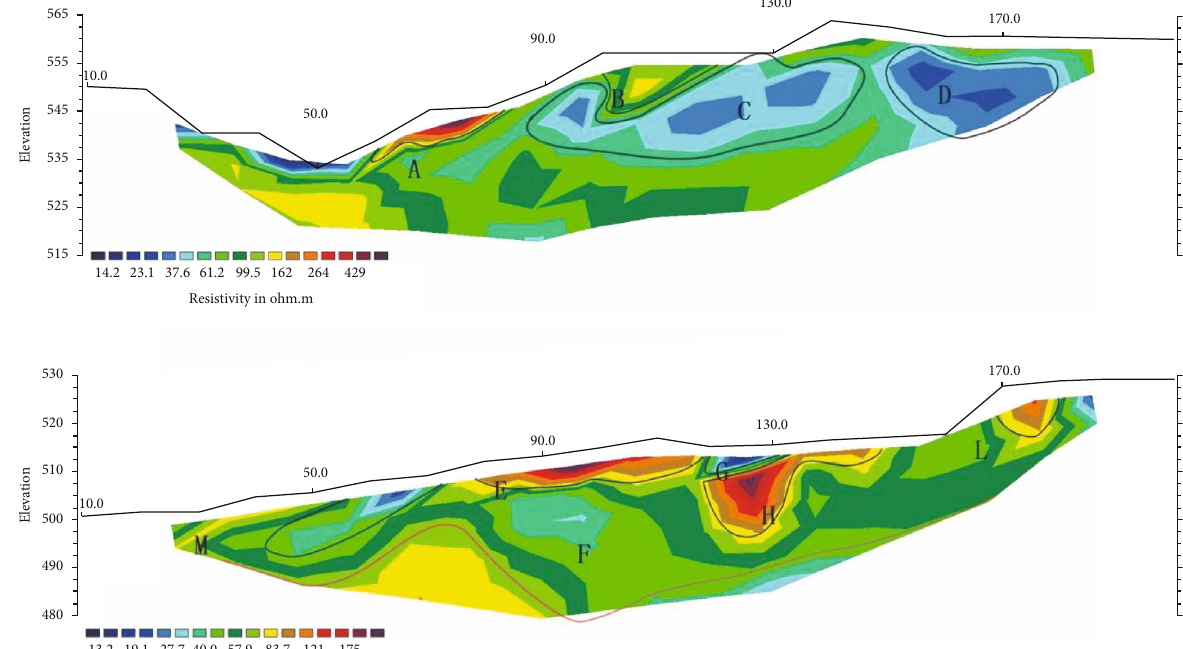
Figure 17: Measurement results in